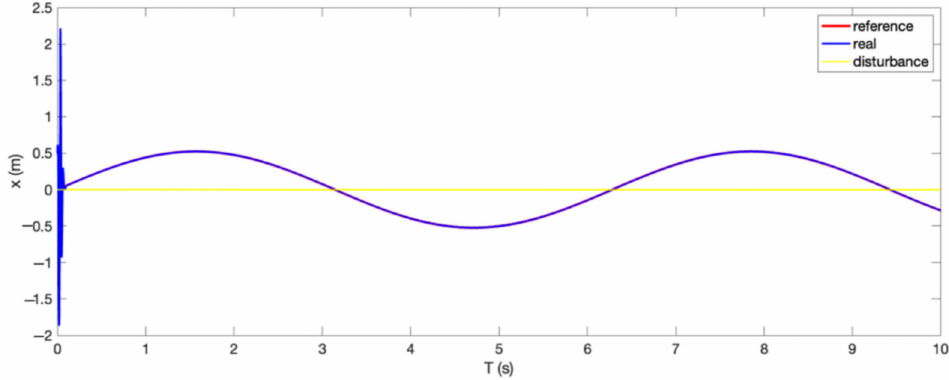
Figure 20. The reference trajectory (red cure) and the system response (blue curve) of the backrest posture control with RBFNN approximation with disturbance (yellow curve).